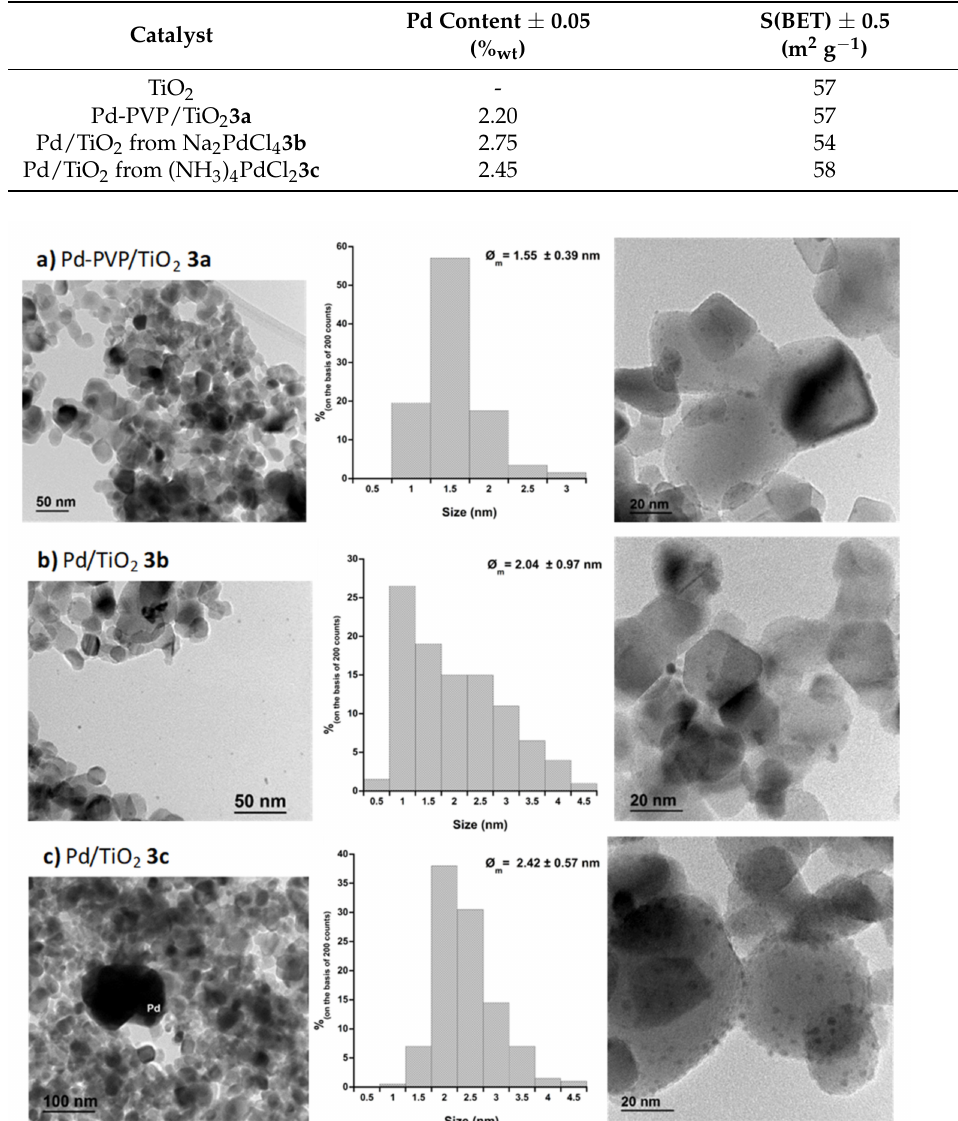
Figure 6. TEM pictures and particle size distribution of the different solids of Family 3 . ( a ) Ob- tained by impregnation of Pd-PVP 1a on TiO 2 . ( b ) Obtained by impregnation of Na 2 PdCl 4 on TiO 2 . ( c ) Obtained by impregnation of (NH 3 ) 2 PdCl 4 on TiO 2